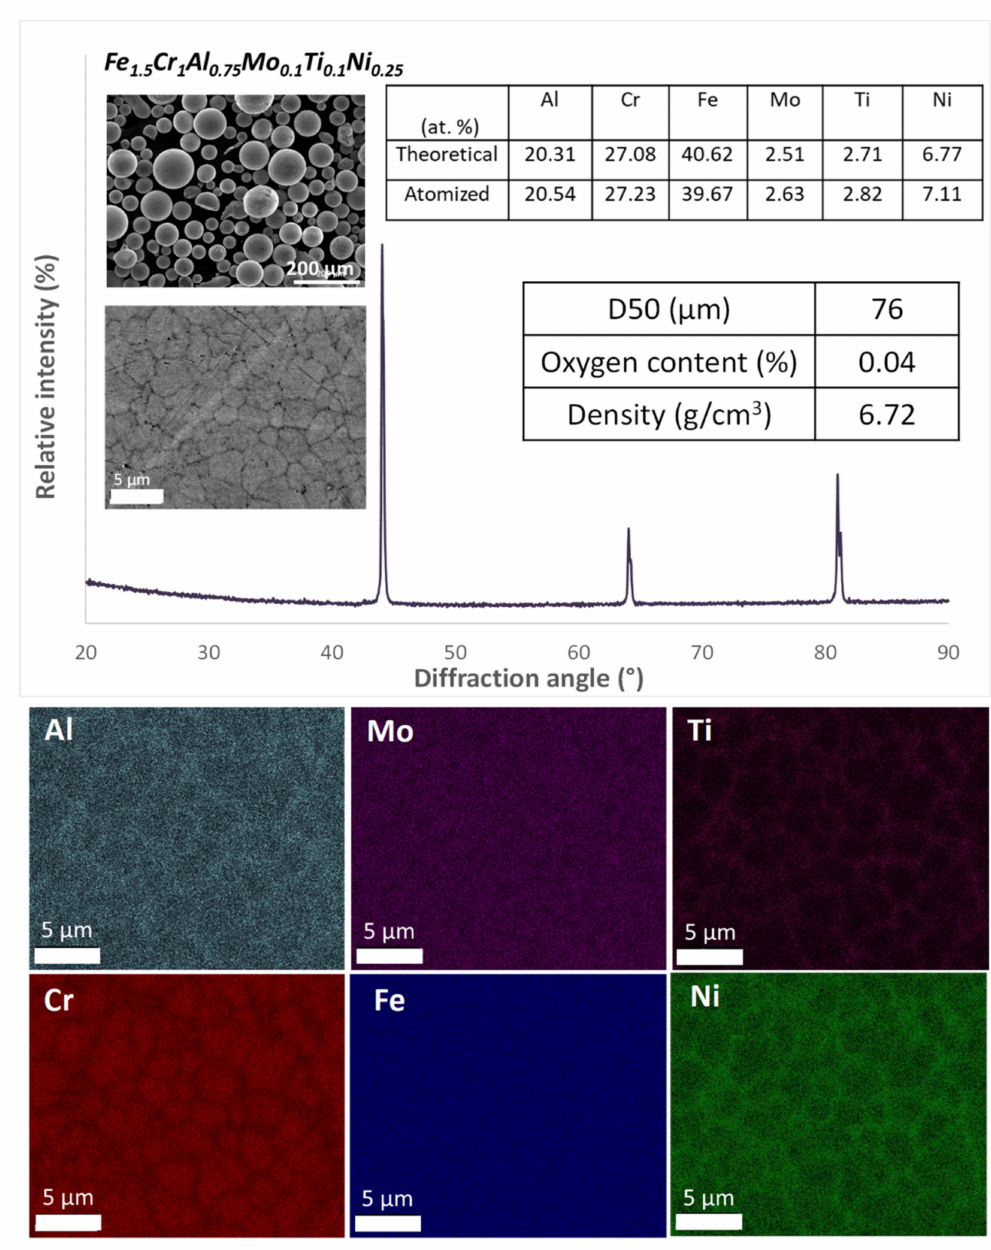
Figure 2. Results of the characterization of FeCrAlMoTiNi atomized powders: the XRD spectra elemental composition, morphology, density, particle size, and oxygen